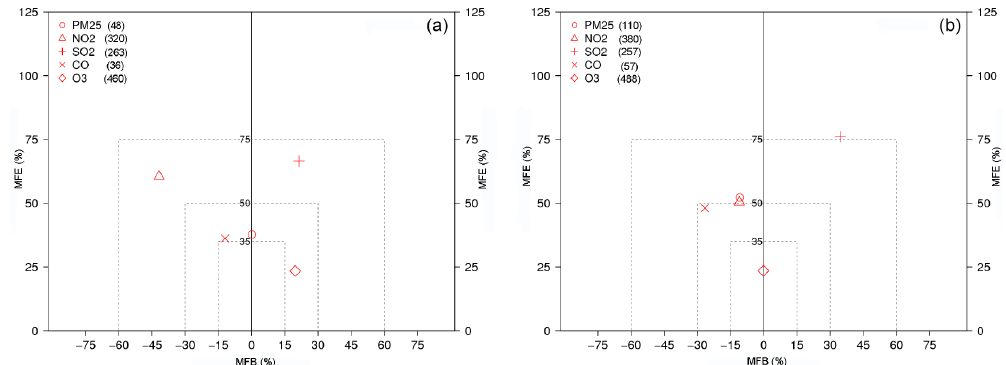
Figure 1. Soccer-goal plots for hourly concentrations of PM 2 . 5 , NO 2 , SO 2 , CO and O 3 in June 2006 (a) and February–March 2009 (b) . The number of measurement stations (AirBase) is indicated in the legend for each species. MFB: mean fractional bias; MFE: mean fractional